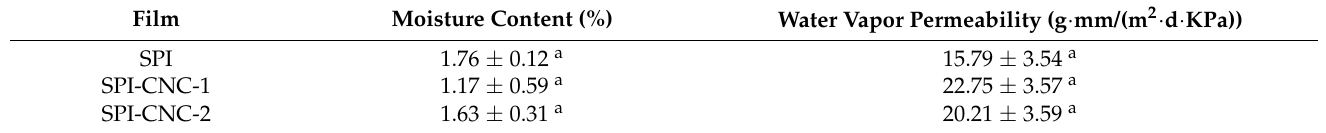
Table 5. The moisture content and water vapor permeability of SPI-based films with different adding amounts of CNC (CNC-1: 0.25%; CNC-2: 5%). Different letters (a–c) in the same column indicated significant differences ( p < 0.05).